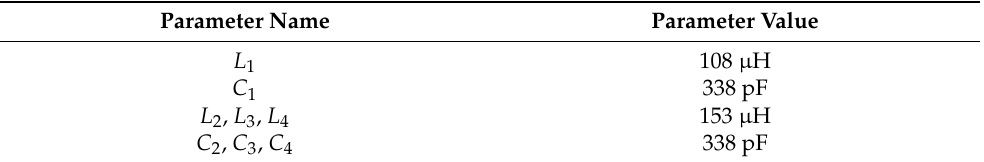
Table 1. Parameters of each component in the experiment.